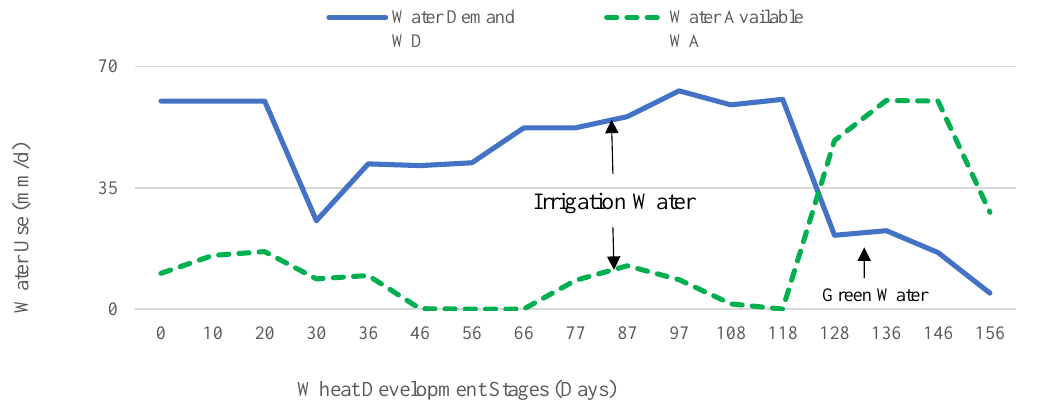
Figure A3. Graphical representation of water demand and water available for wheat .